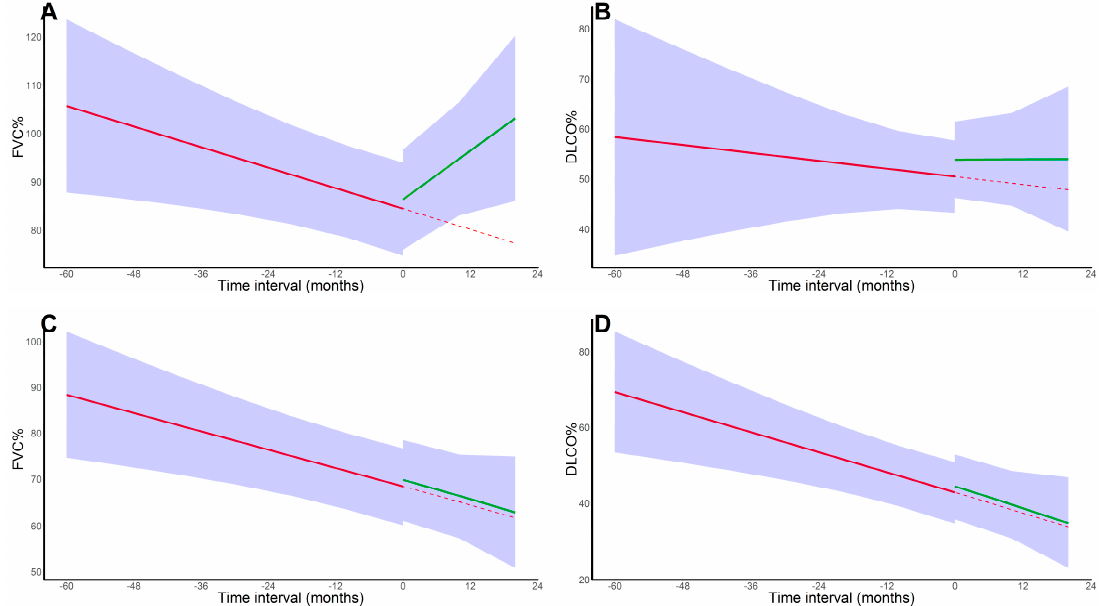
Figure 3. Pulmonary function test evolution in corticosteroid-treated patients . ( A ). FVC% trajectory in nfHP patients; ( B ). DLCO% trajectory in nfHP patients; ( C ). FVC% trajectory in fHP patients; ( D ). DLCO% trajectory in fHP patients. For FVC%, a positive effect of corticosteroid initiation was seen in nfHP, whereas this effect was absent in the fHP group. For DLCO%, no impact on decline was observed however, nfHP patients experienced an immediate numerical increase in DLCO% after treatment initiation. The solid red line represents the mixed effect model estimates before corticosteroid initiation, the solid green line represents the mixed effect model estimates after corticosteroid initiation and the dotted red line represents the pre-treatment trend. Subject was corrected for as a random effect, both with random intercept and (independent) random slope. Fixed effects were time, age, gender, ever smoker status, and immunosuppression use. Definition of abbreviation: nfHP, non-fibrotic hypersensitivity pneumonitis; fHP, fibrotic chronic hypersensitivity